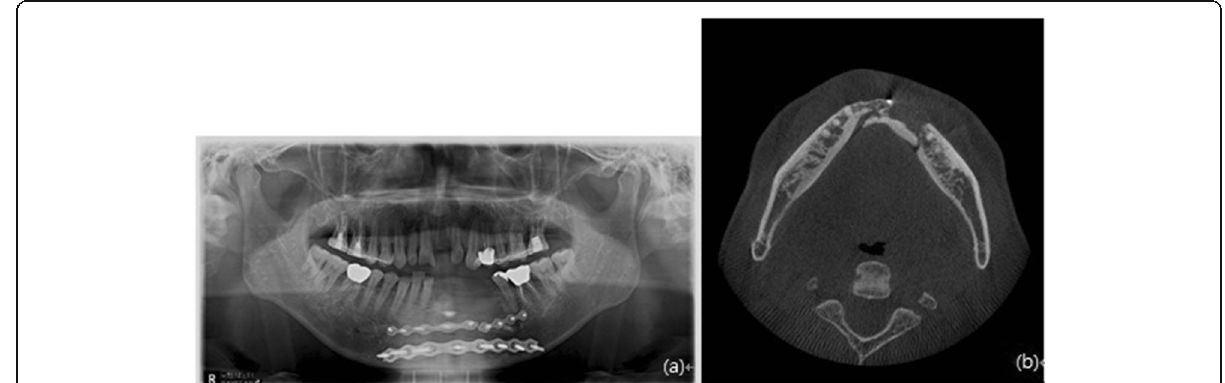
Fig. 4 Preoperative radiograph. a Panoramic radiograph and b conical beam computed tomography